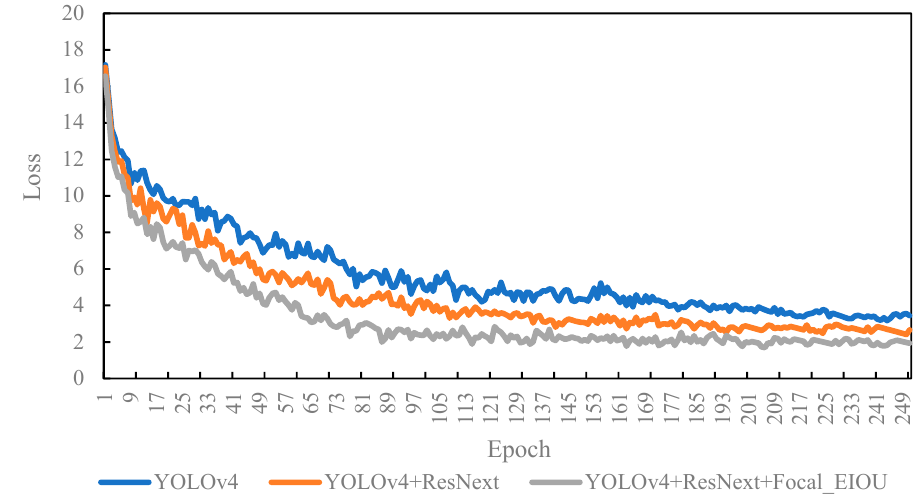
Figure 5. Training loss curves of the YOLOv4 and improved model.